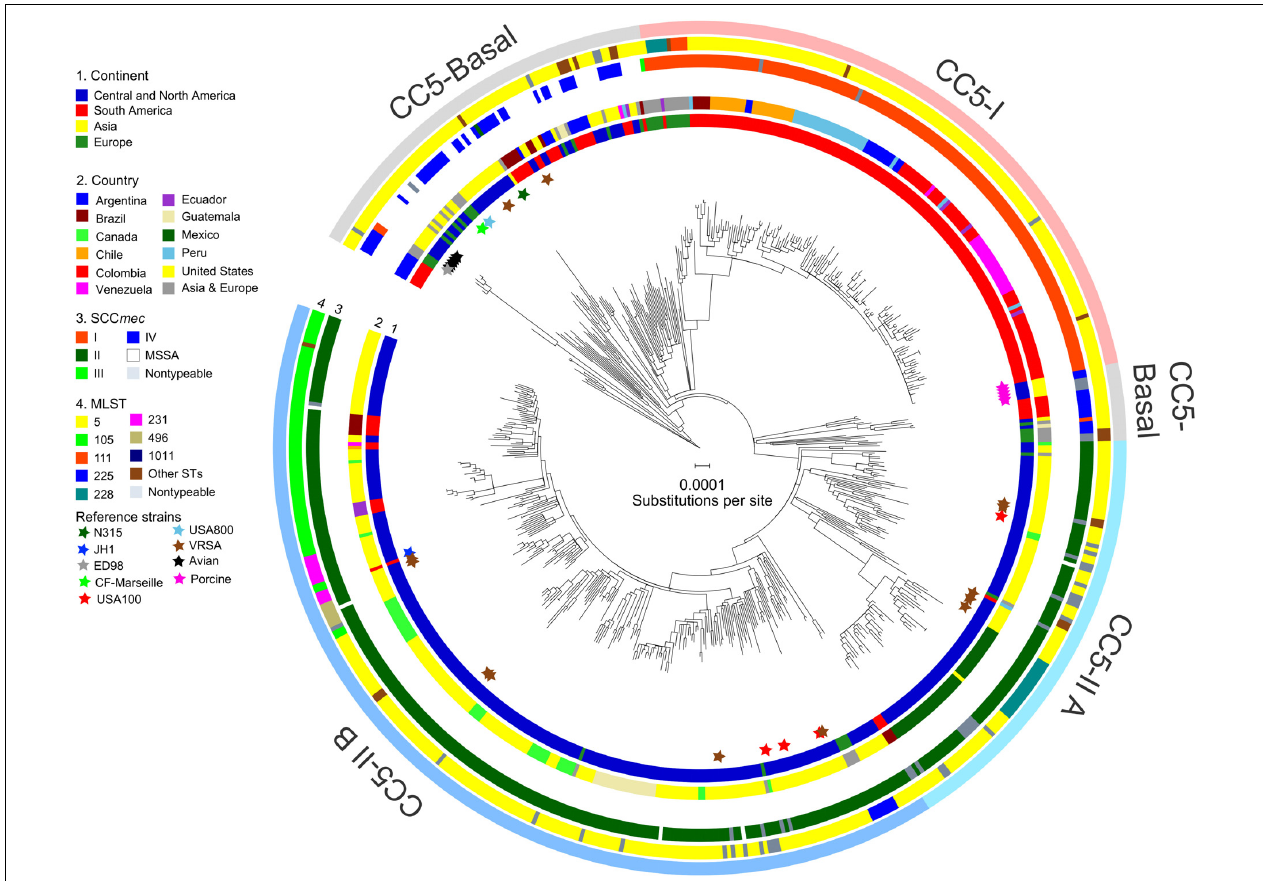
FIGURE 1 | Phylogeny of CC5. The ML phylogeny has recombination-corrected branch lengths and is outgroup-rooted. The major clades of CC5-Basal, CC5-I, and CC5-II are indicated with shading. The statistical support for these clades is described in the text. The positions of reference strains are indicated with stars. The four rings in the direction of inner-outer, show continent (ring 1), country (ring 2), SCC mec type (ring 3), and multilocus ST (ring 4) for each genome. STs with less than three genomes were combined into “Other STs” for display purposes. Scale bar indicates number of substitutions per